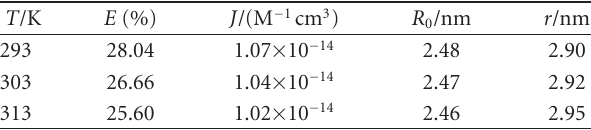
Table 3: Parameters of E , J , r , and R 0 between Avelox and BSA at di ff erent